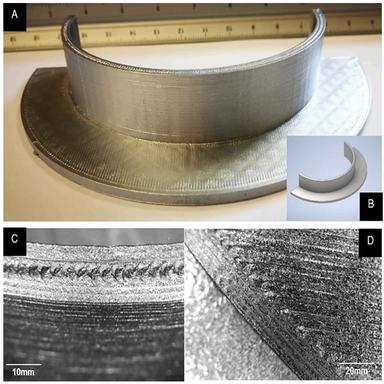
The fabrication of an optimised 3D MAG printed component (A) photograph of the gasket structure (B) computer aided design of the structure (C) micrograph taken of the top region showing the fusion of the weld material to the inner and outer shell and (D) micrograph taken of the top showing the formation of the shell structure and stainless steel infill.